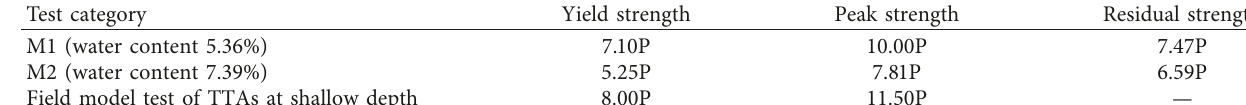
Table 3: The bearing test results of soft rock tunnel anchor rock [38].